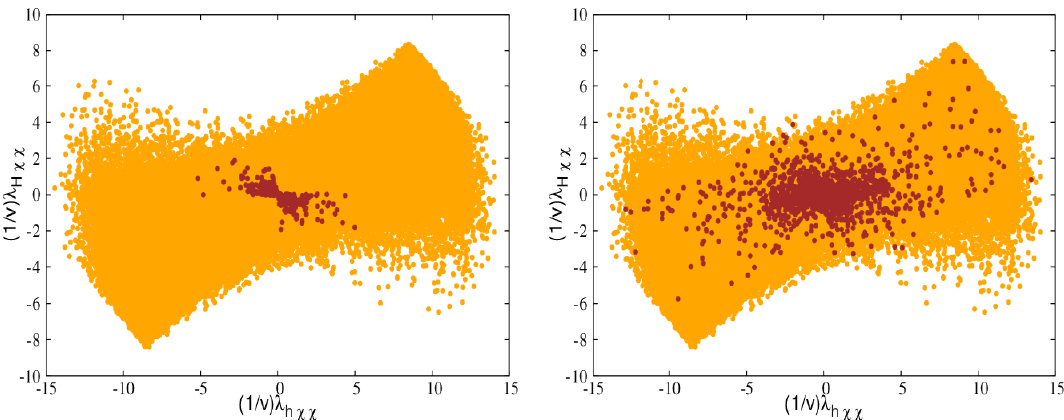
Figure 3 . Scatter plot in the λ plane for Type I (top) and Type II (bottom) 2HDM. hχχ − λ Hχχ Color code is same as in figure 2.